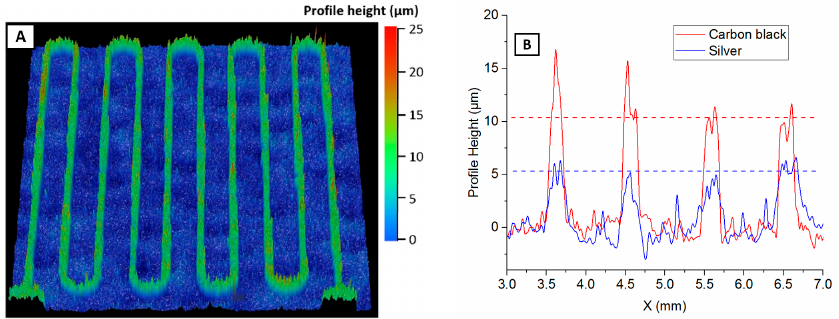
Figure 3. 3D scan ( A ) and printed line profiles of the silver and carbon black sample ( B ) with linewidth of 200 μ